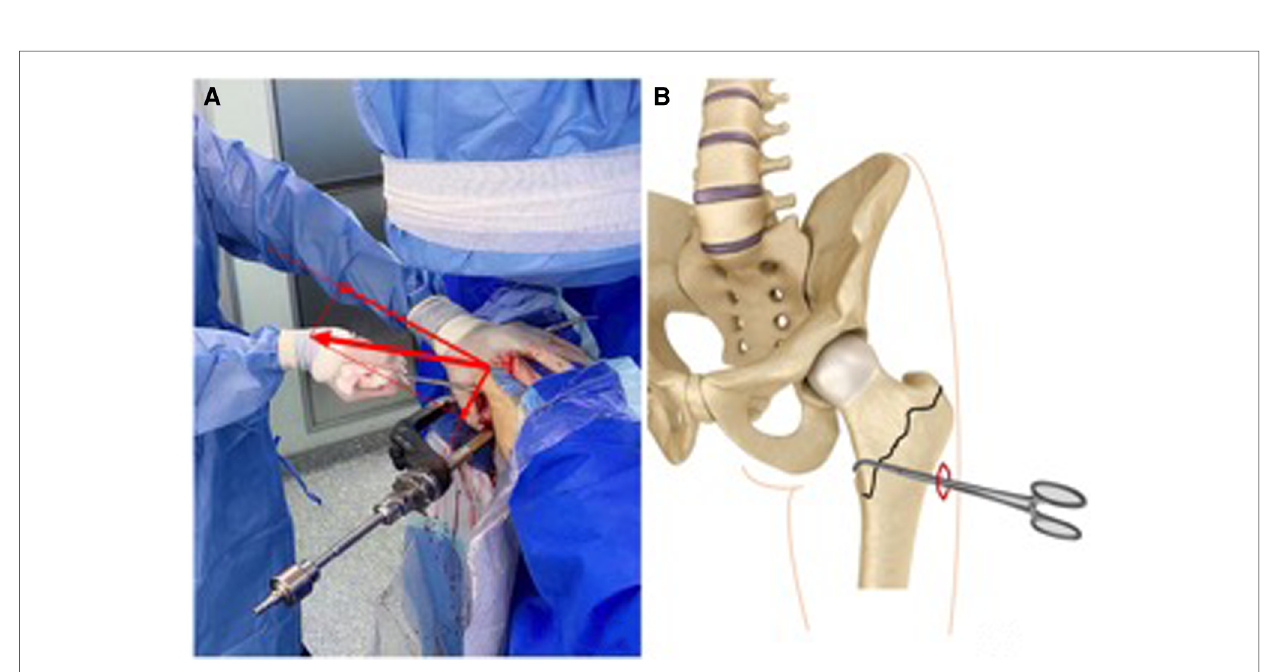
FIGURE 3 The minimally invasive reduction techniques were performed as follows: ( A ) the assistant surgeon palpated and pried the medial arch fragments. ( B ) Diagram of the minimally invasive reduction techniques: the right-angle forceps were passed anteriorly to assist the reduction of the medial arch fragments even the displaced lesser trochanter through the cephalomedullary